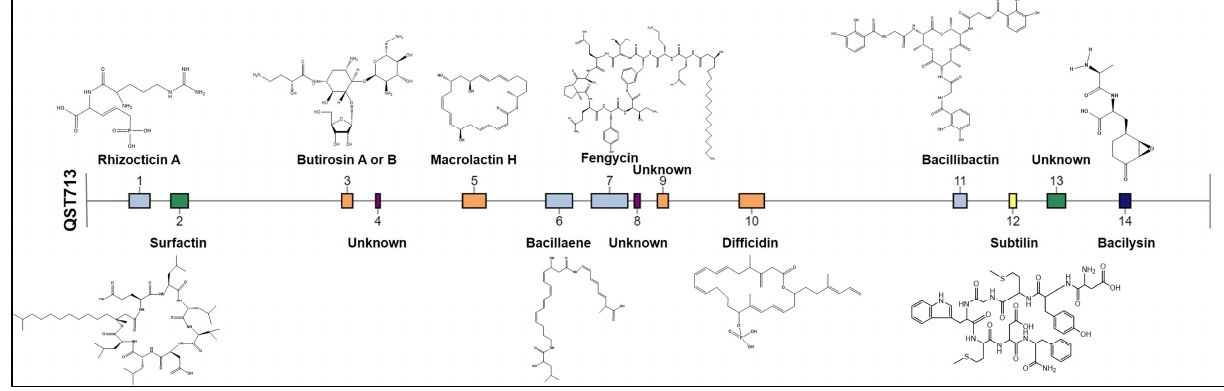
Figure 1. Antimicrobial gene clusters identified in the genome of the B. velezensis QST713 strain.